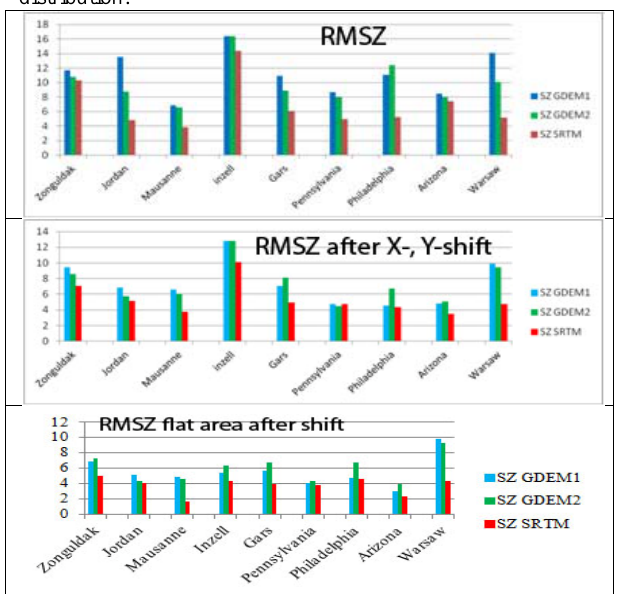
Figure 6: Root mean square discrepancies of SRTM, ASTER GDEM and ASTER GDEM2, originally, after horizontal adjustment, after horizontal adjustment for flat